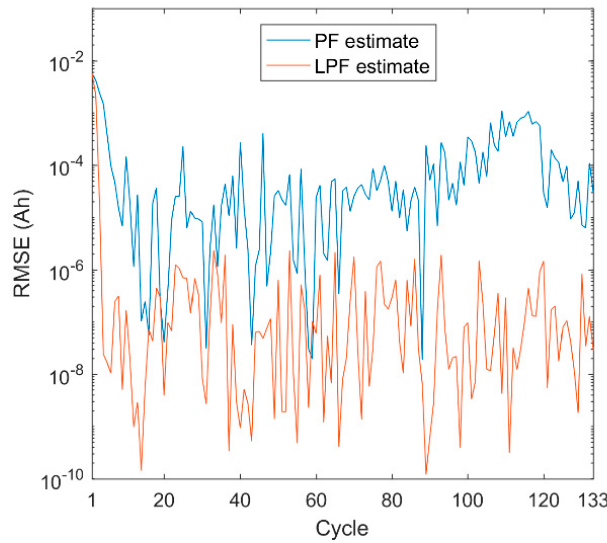
Figure 11. One-step-ahead estimates of capacity degradation trends for battery B18: ( a ) PF; ( b ) LPF.